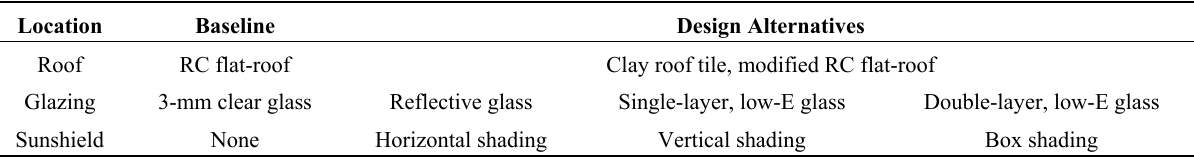
Table 3. Design alternatives under investigation.